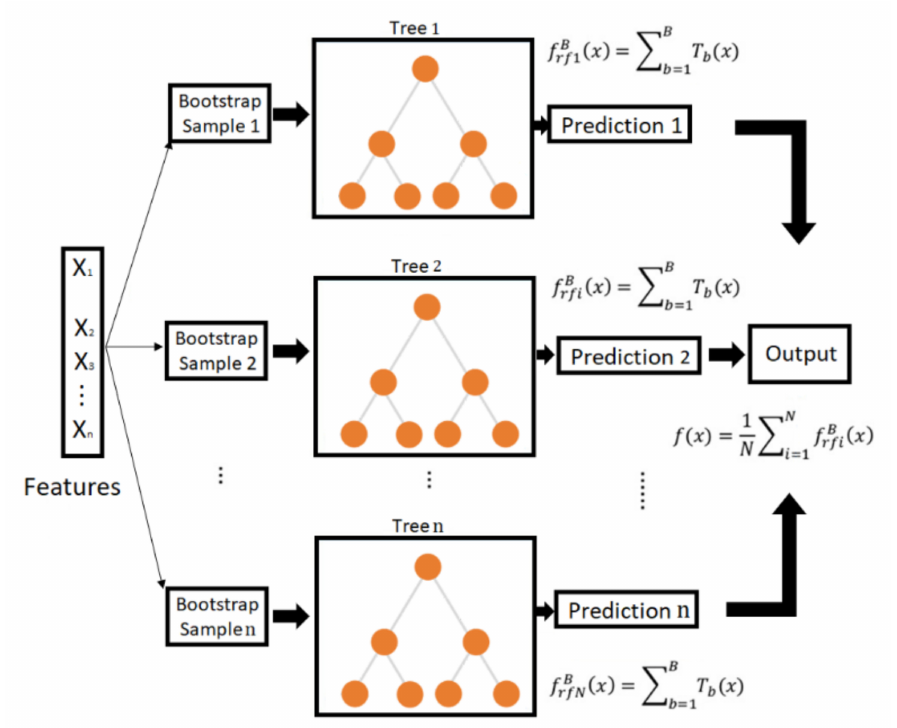
Figure 4. Schematic of tool wear prediction using